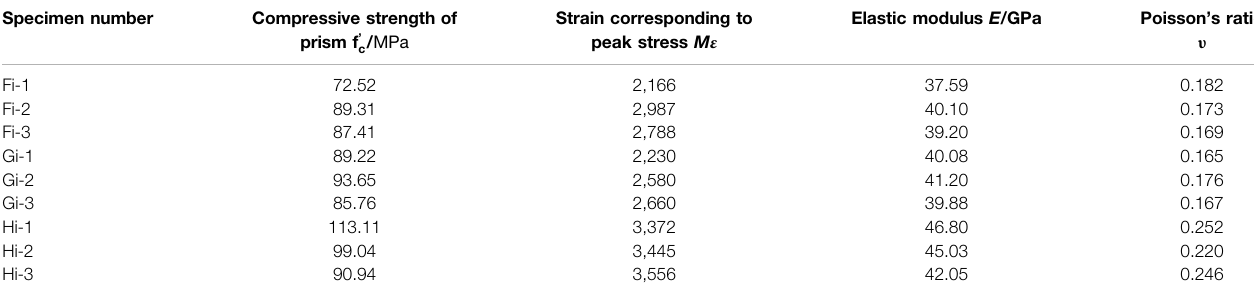
TABLE 4 | Test values of compressive mechanical indexes of 3 groups of prism specimens. Specimen